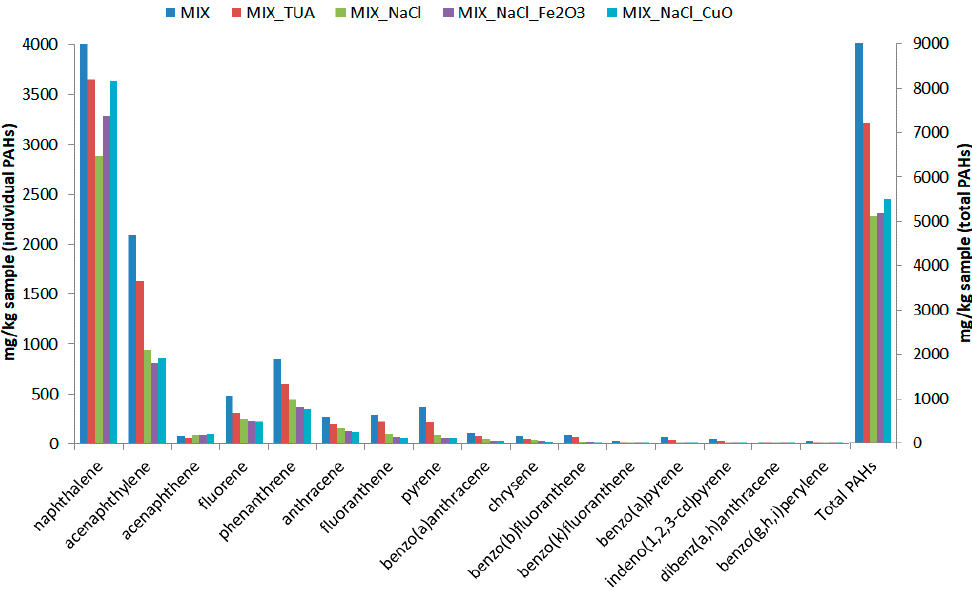
Figure 1. Emissions of polyaromatic hydrocarbons (PAHs) during the combustion process at 850 °C (mg/kg sample).